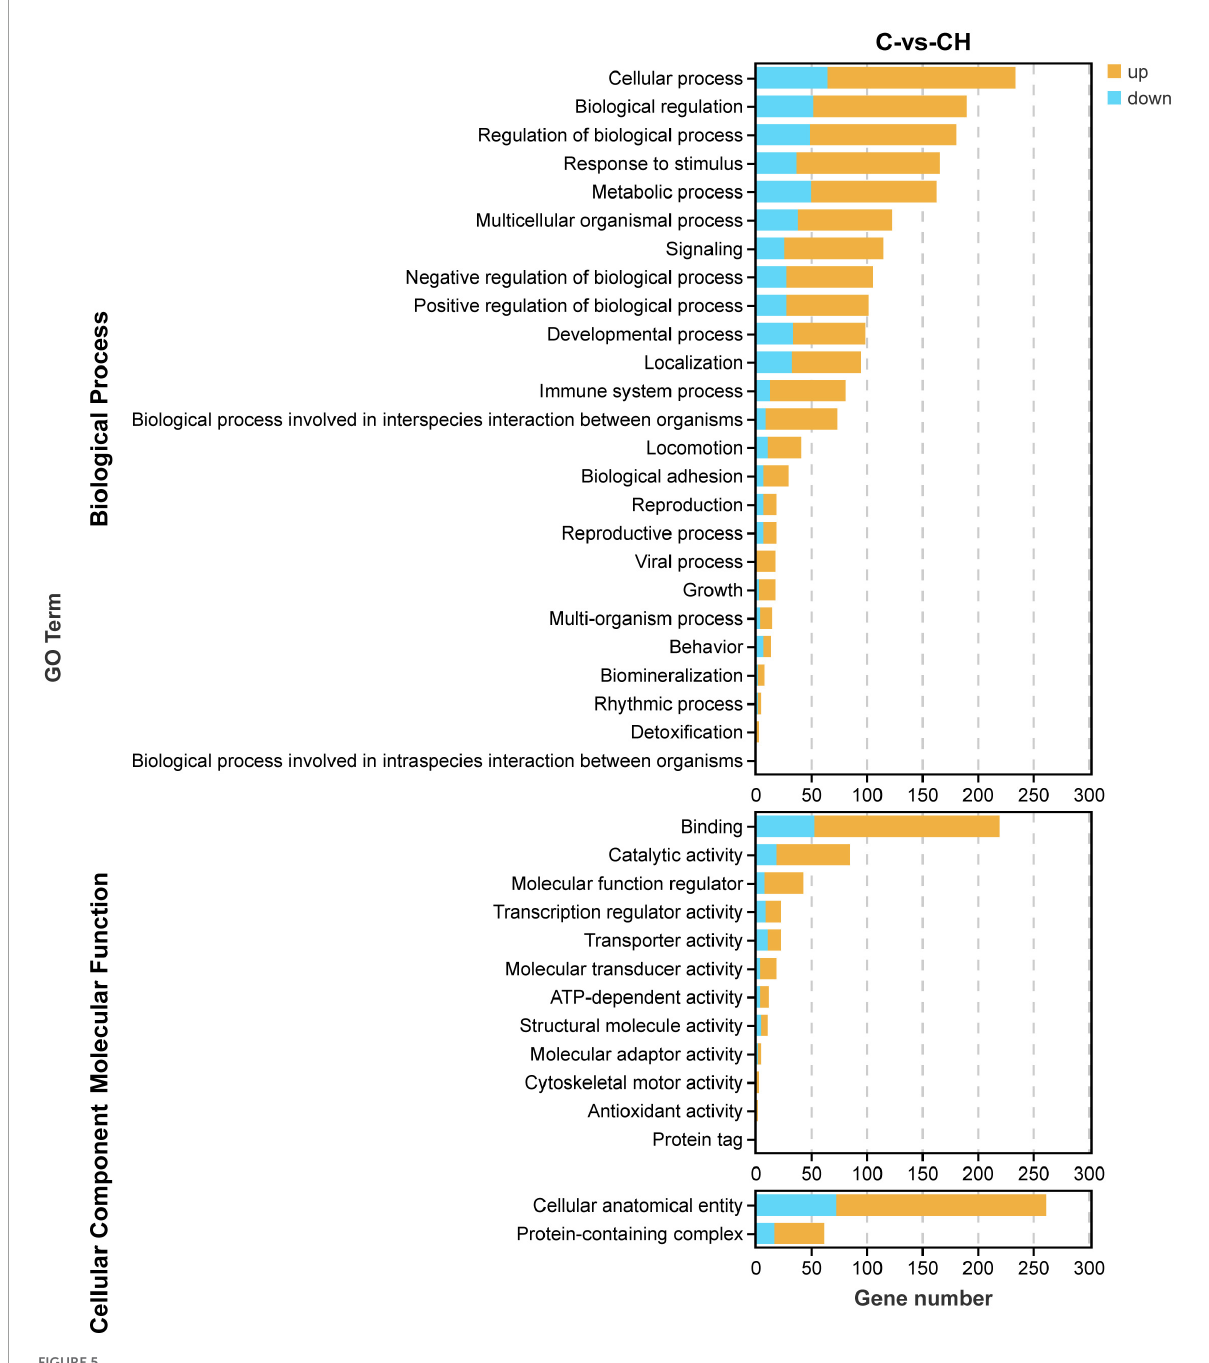
3T3-L1 cell differentiation via promoting the expression of RARRES2